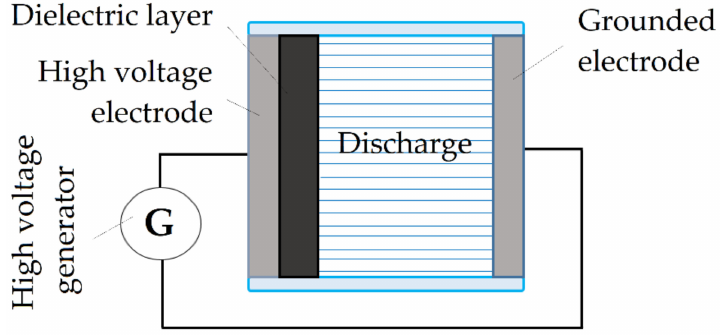
Figure 4. DBD device used for surface cleaning.